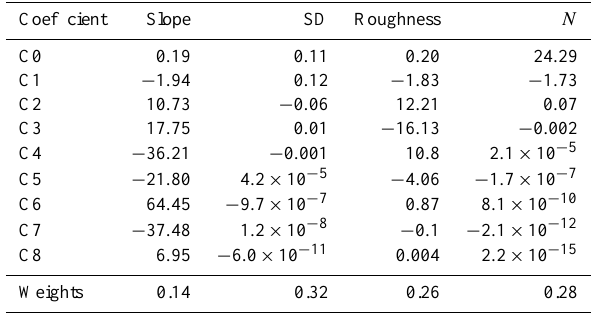
Table A1. Polynomial fit coefficients and weights used for the Greenland uncertainty